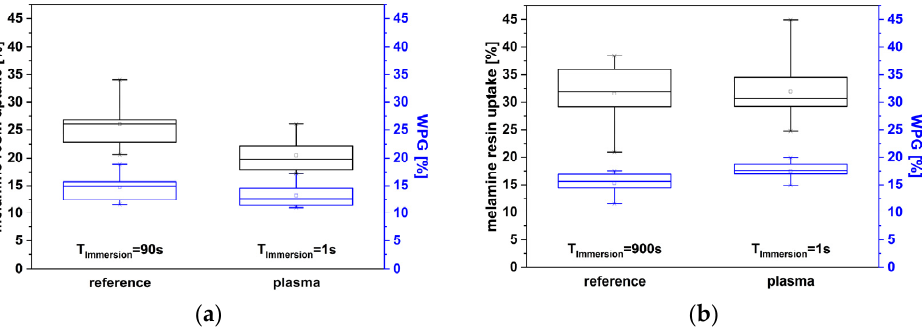
Figure 3. Melamine resin uptake and WPG of native ( a ) and thermally modified ( b ) beech veneers. Error bars display the standard deviation.